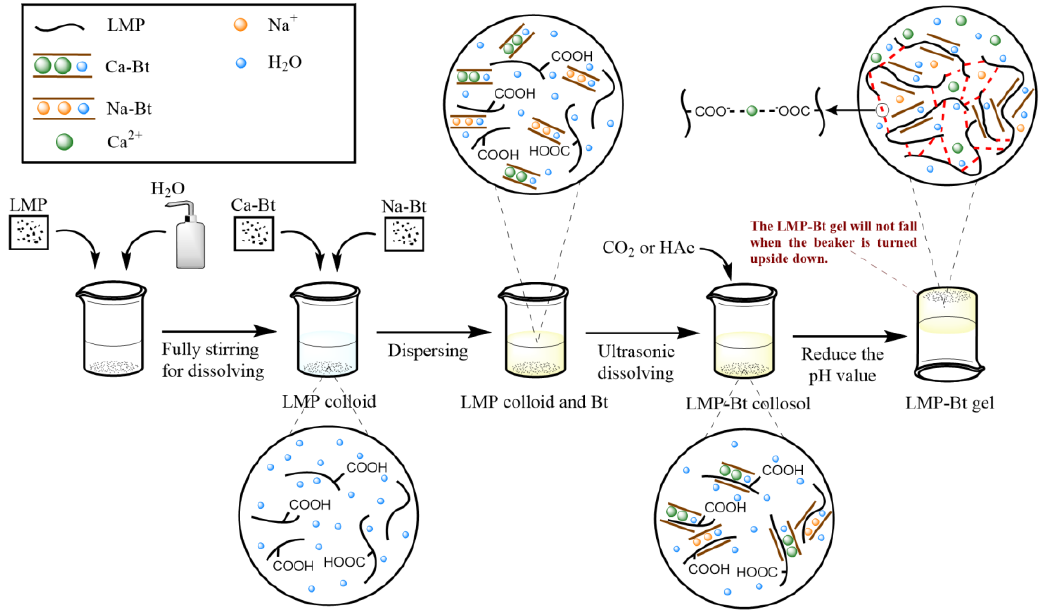
Figure 15. Production process of LMP-Bt colloid.